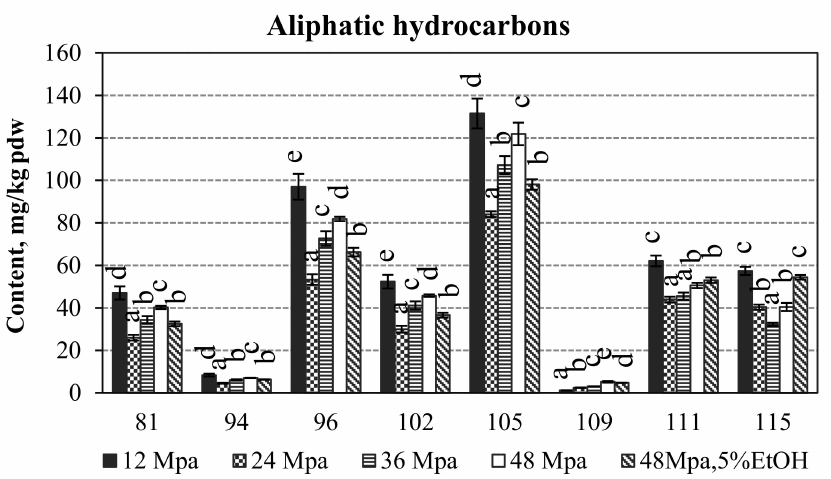
Figure 3. The absolute amounts of aliphatic hydrocarbons in Narcissus poeticus SFE-CO 2 extracts, in mg/kg pdw. Constituents are numbered by the same order as provided in Table 2. Values within columns followed by the same letter (a–e) do not differ statistically at p < 0.05 (Duncan